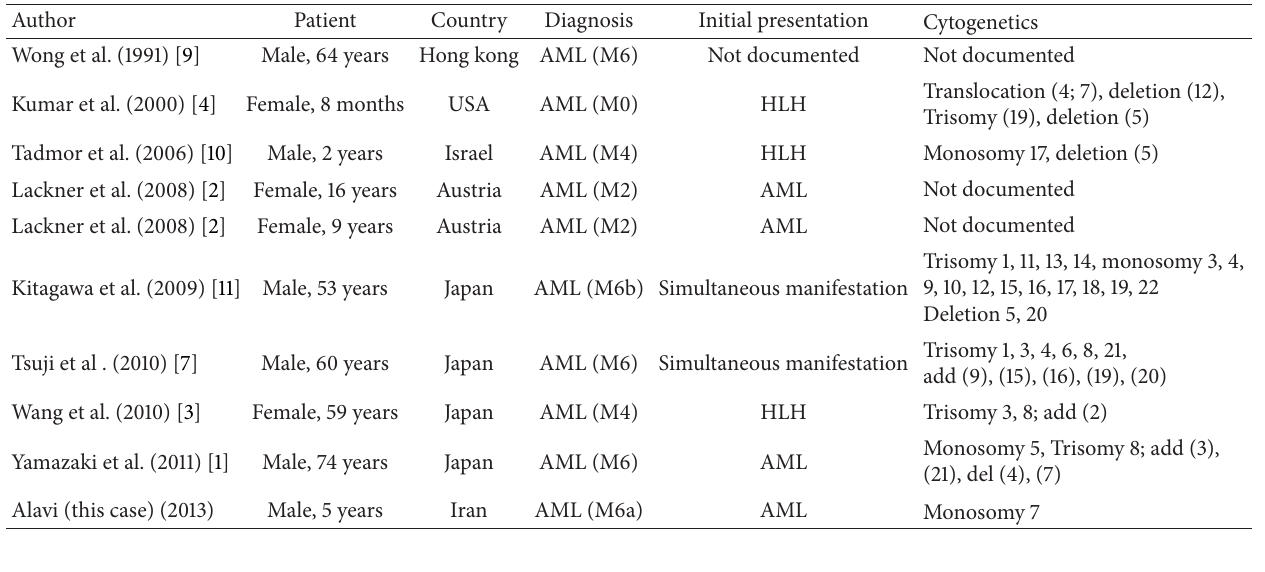
Table 1: Cases with AML associated with HLH.